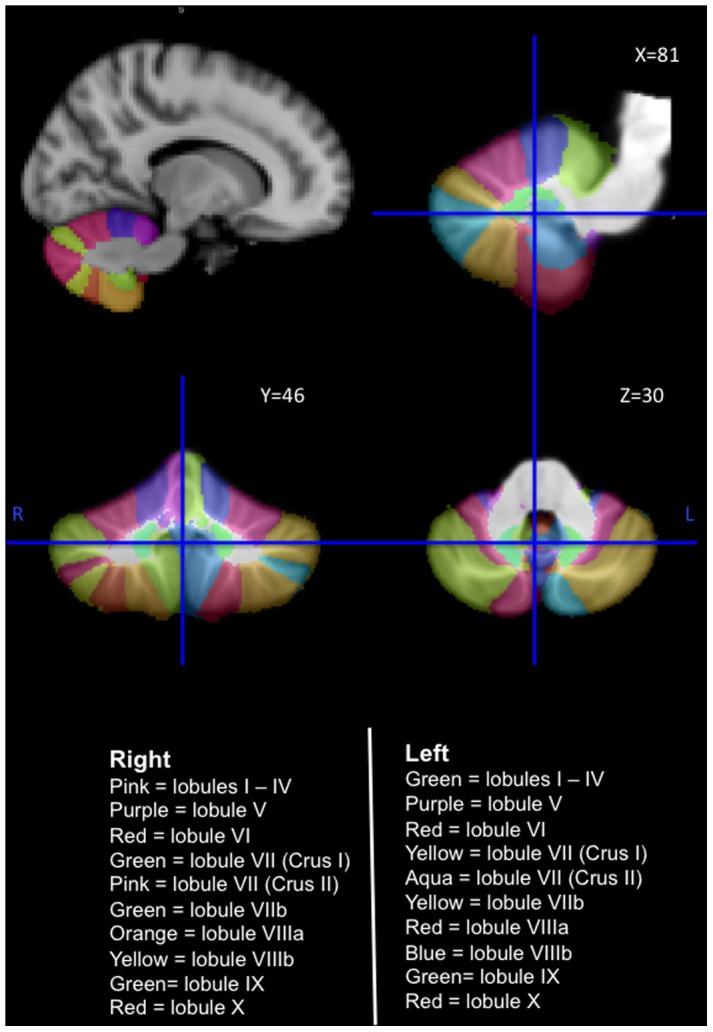
The human cerebellum with lobules I–X labelled from the probabilistic atlas template (SUIT) of the human cerebellum (http://www.icn.ucl.ac.uk/motorcontrol/imaging/propatlas.htm).
L Left Hemisphere; R Right Hemisphere.